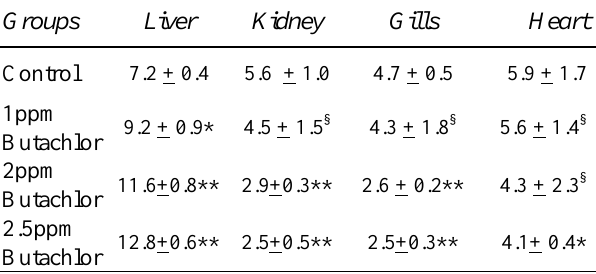
Table 4: The concentrations of Glutathione (nmol/mg protein) in the liver, kidneys, gills and heart of Clarias gariepinus exposed to Butachlor Groups Liver